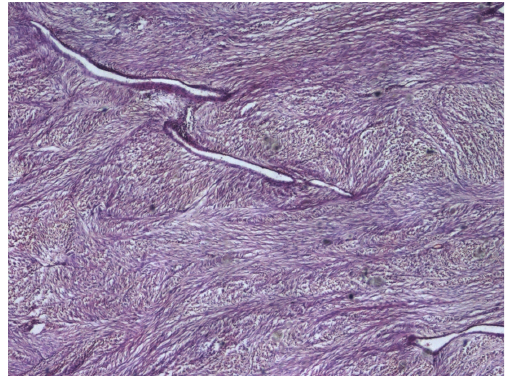
Figure 4: Photomicrograph (H&E stain; original magnification × 40) showing oval to spindle cells arranged in fascicles.